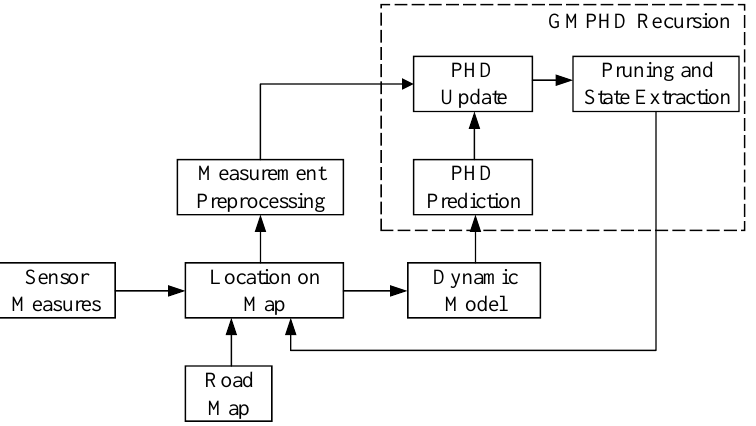
Figure 1. Framework of the directional process noise Gaussian mixture probability hypothesis density (DPN-GMPHD) filter.